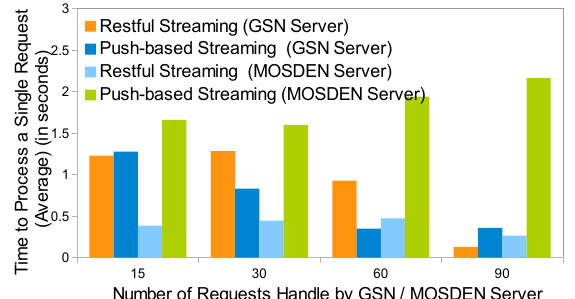
Figure 16. Comparison of Data Retrieval and Processing